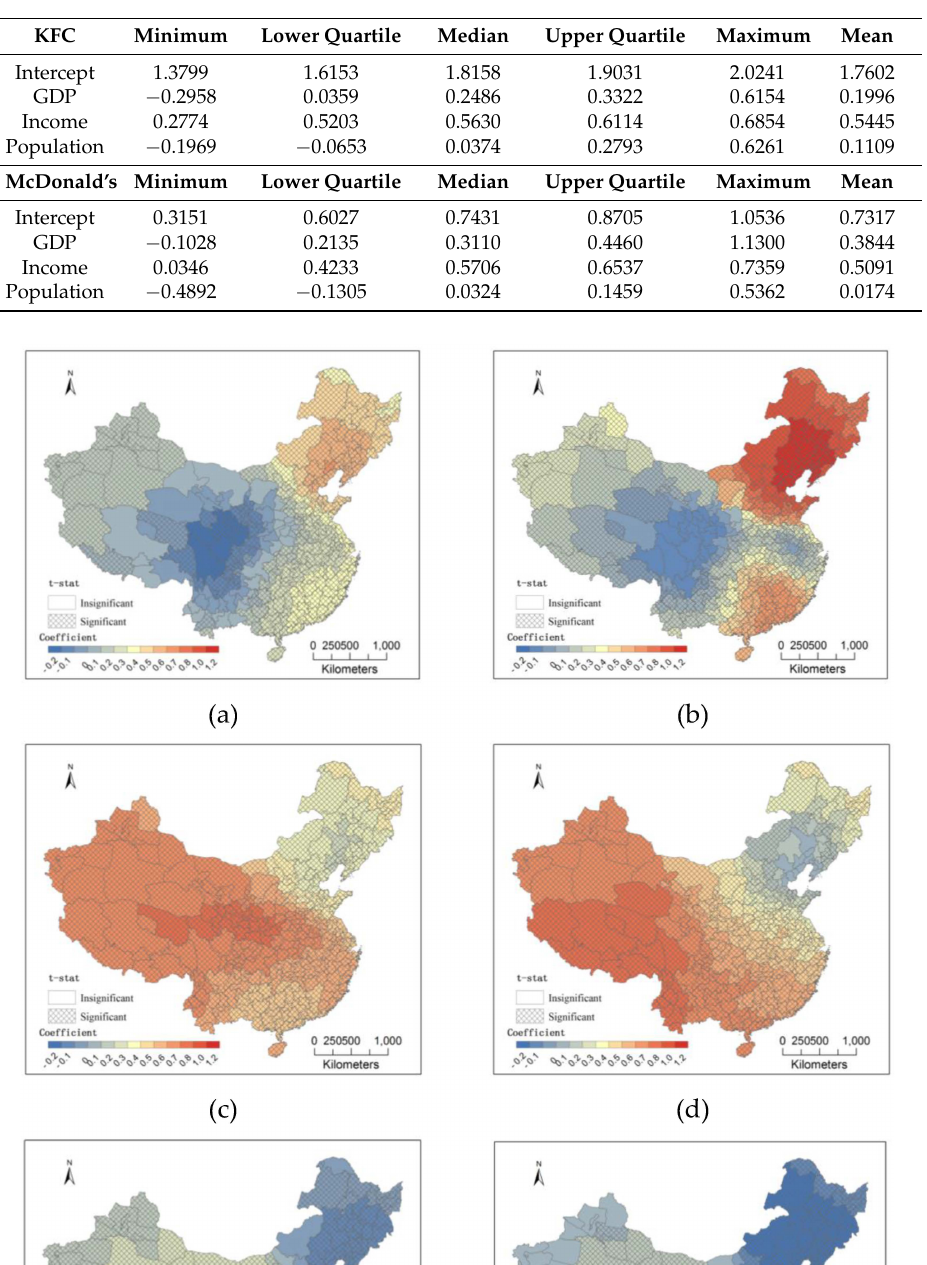
Table 4. Statistics for varying the (local) coefficients.